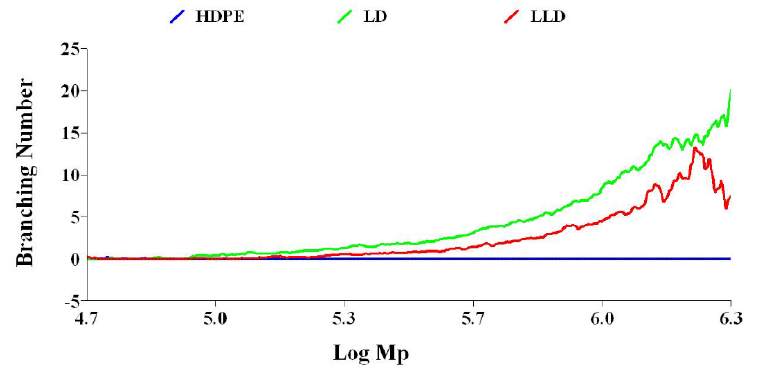
Figure 7. Diagram of g vs. log molecular weight for polyethylenes.